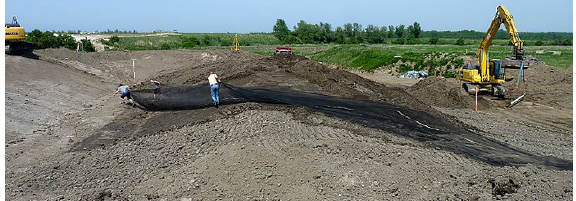
Fig. 13. Geogrid installation